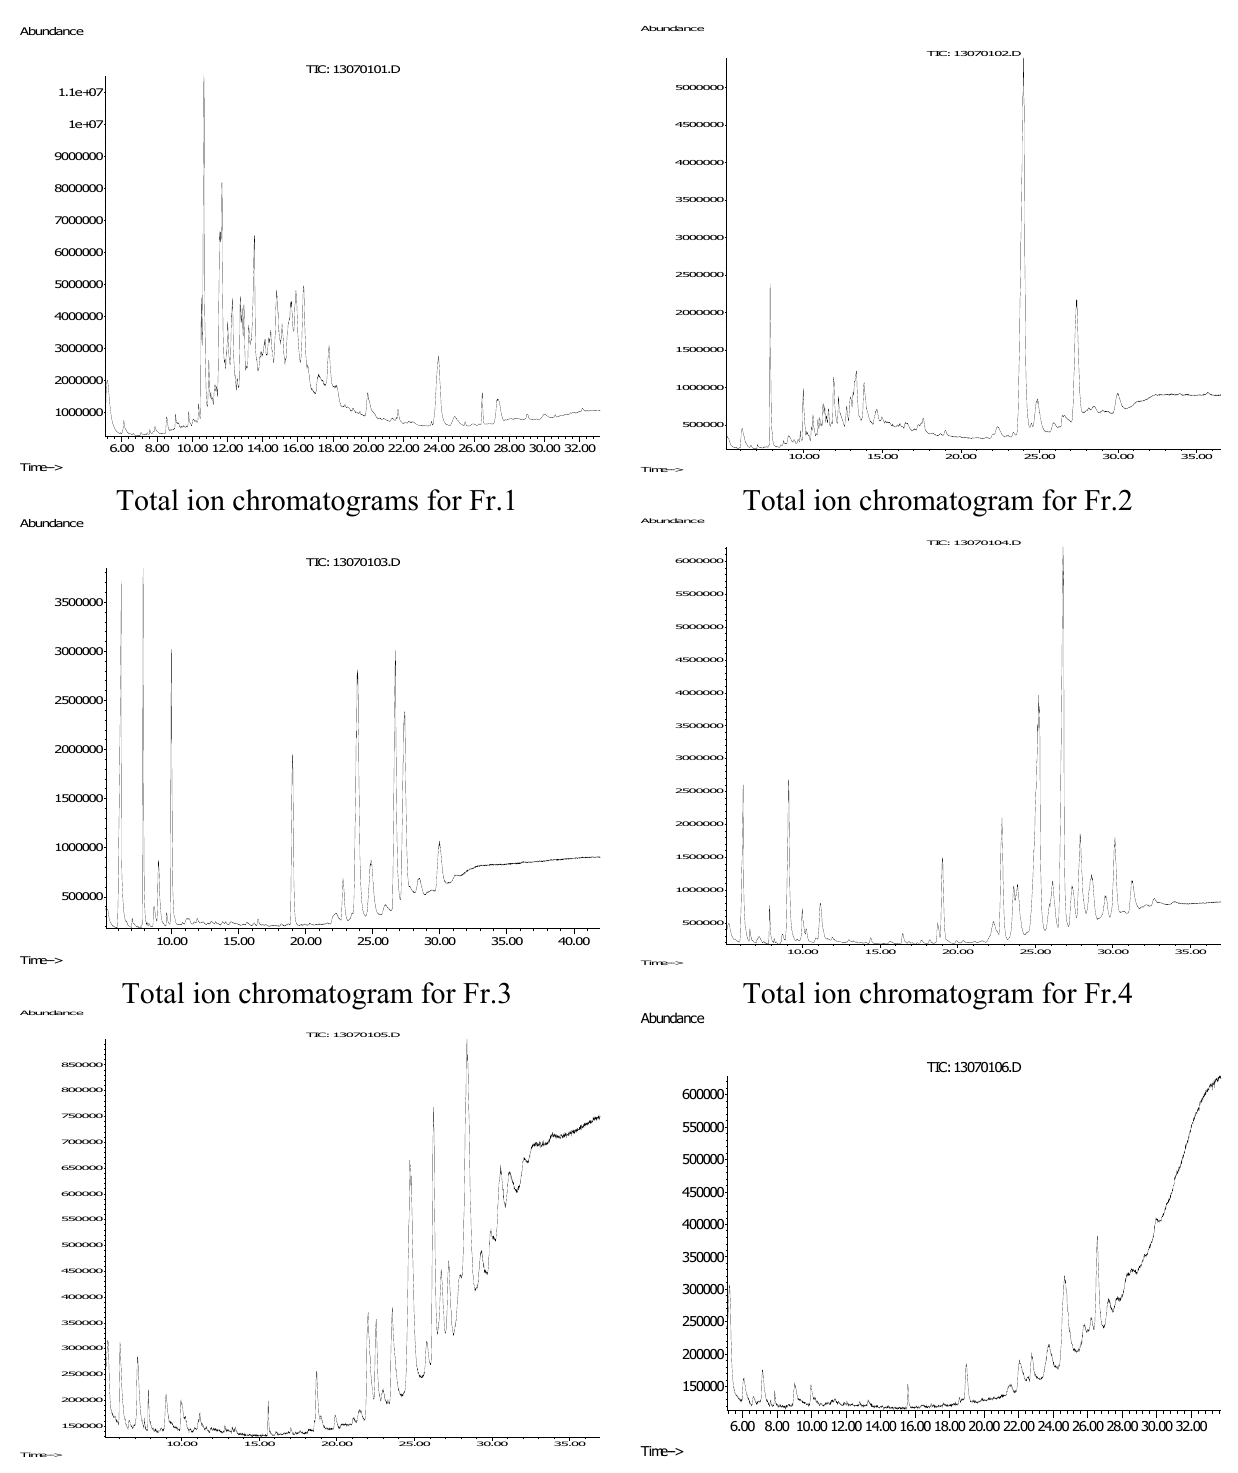
Figure 3. Total ion chromatogram for Fr.1~6 of agarwood